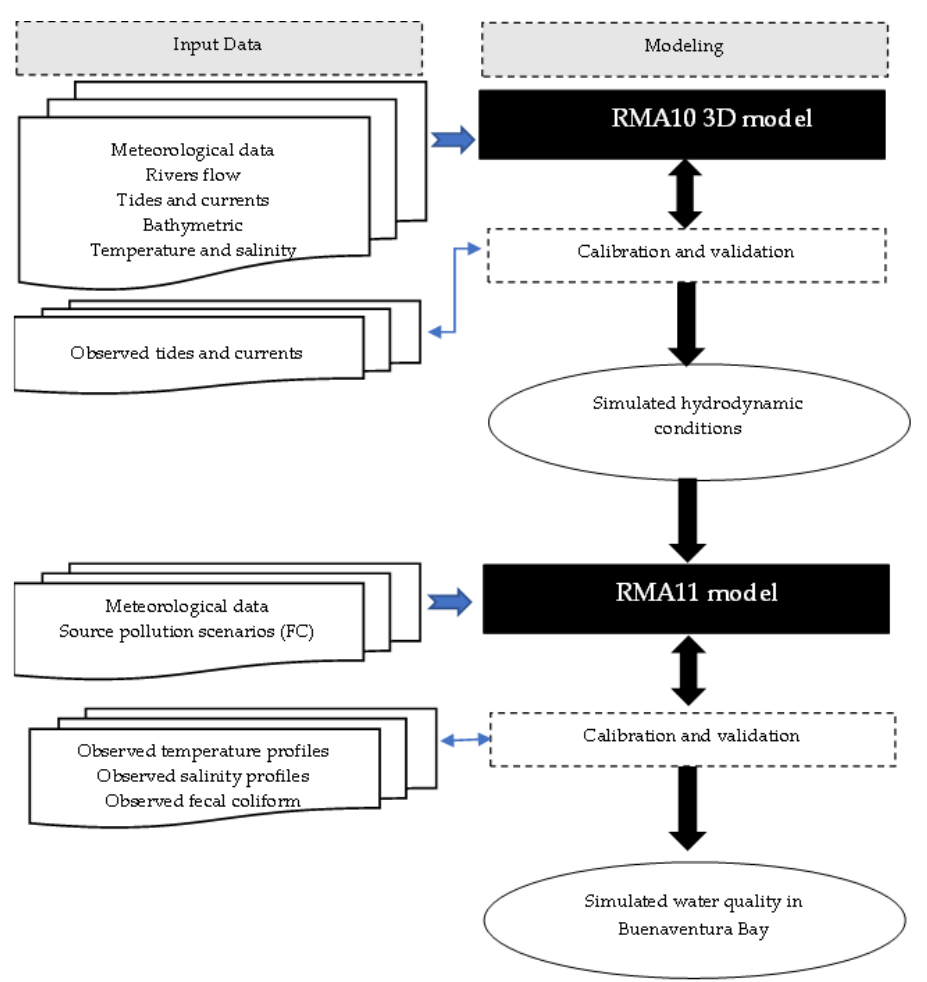
Figure 3. One-way coupling scheme for RMA10 and RMA11 models .